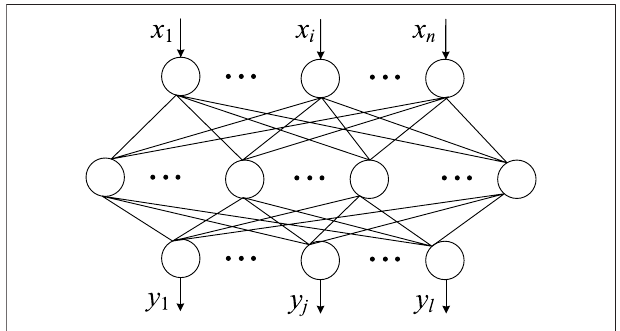
FIGURE 2 | BP neural network structure